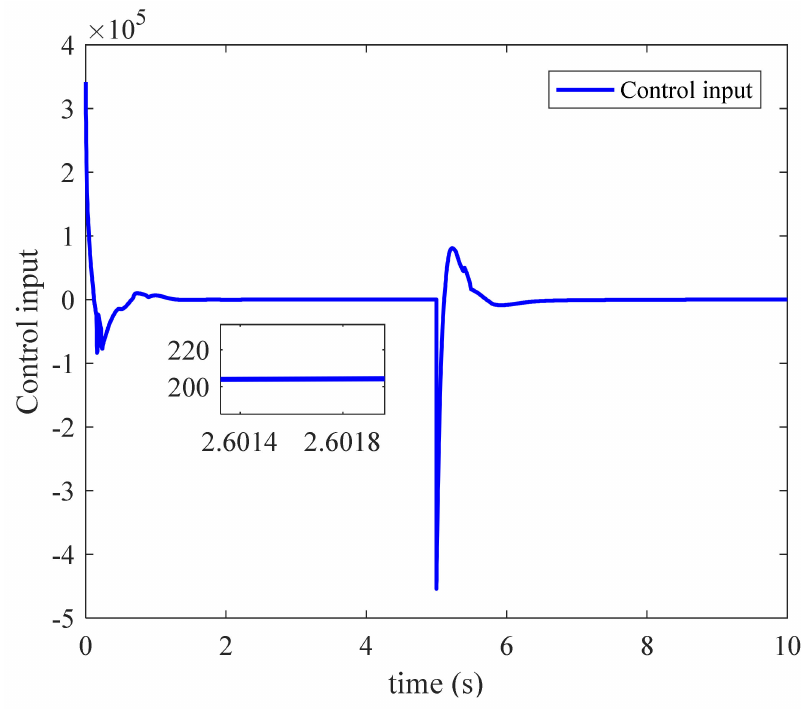
Figure 11. Time response of the control input.